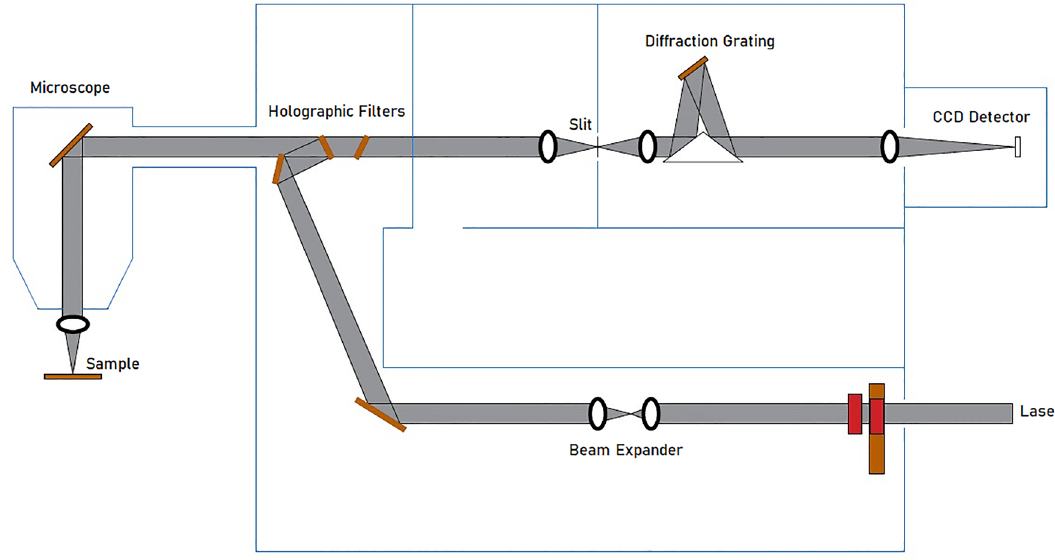
Figure 1. Schematic diagram of geometrical set-up of a Renishaw Raman system for Raman and PL measurements, adapted from literature 27,28 and drawn using AutoCAD LT